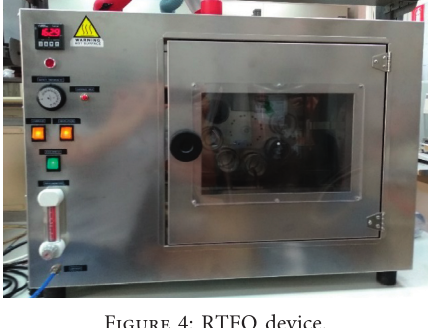
Figure 4: RTFO device.